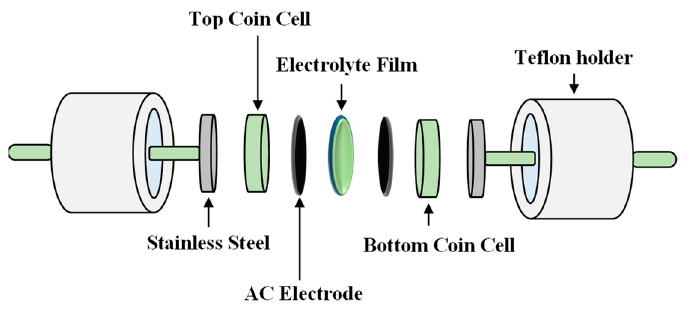
Figure 1. The schematic diagram of an EDLC cell. Adapted from reference